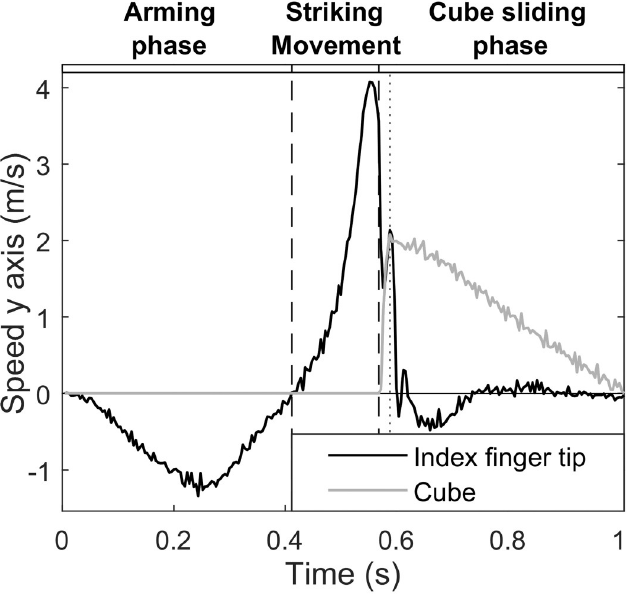
Fig 2. Segmentation of the ballistic gesture and cube movement. Three phases were taken into consideration on the basis of both index fingertip and cube speed along the main axis of the experimental setup (the gutter). The initial arming phase started when the participants moved their index fingertip back away from the cube, and ended when the arm stopped at its maximal extension with speed equal to zero. During the striking movement, the hand moved towards the cube with increasing speed until impact. The start of the cube sliding phase corresponded to the index- cube initial contact duration concomitant with a mutual speed change reflecting energy transfer from the finger to the cube which started to